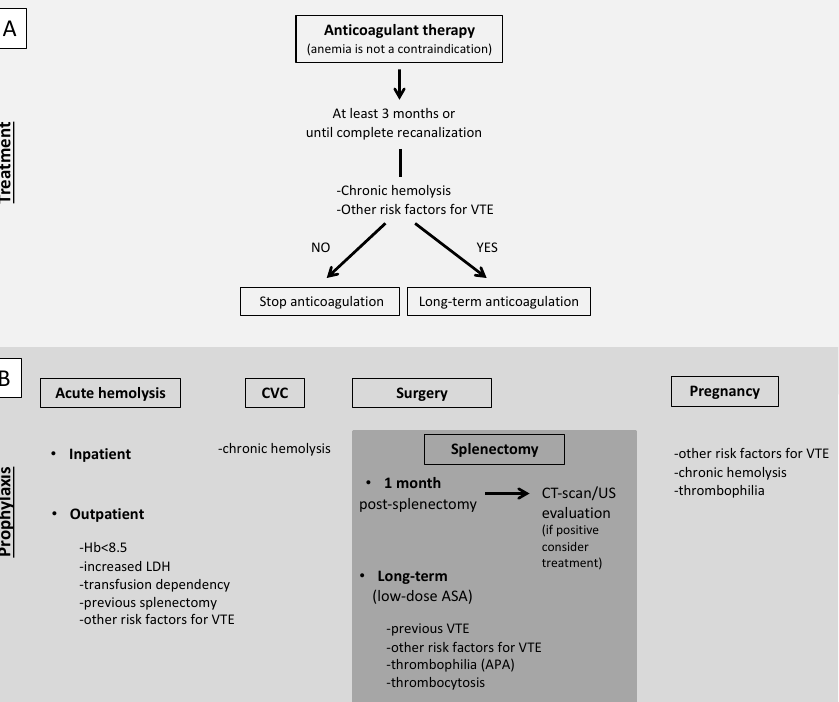
Figure 2. Proposed recommendations for treatment ( A ) and prophylaxis ( B ) of VTE in AIHA patients. ( A ). Anticoagulant therapy should be promptly started, regardless the degree of anemia, and continued for at least 3 months or until complete recanalization. Even if complete recanalization is reached, long-term anticoagulation should be considered for secondary prophylaxis of VTE, evaluating the presence of persistent risk factors for VTE. ( B ). Antithrombotic prophylaxis with low-molecular-weight heparin is recommended for inpatients with acute hemolysis and should be considered for outpatients with acute hemolysis associated with severe anemia, particularly in splenectomized patients or in the presence of concomitant risk factors for VTE. In patients with acute hemolysis undergoing central venous catheter positioning, antithrombotic prophylaxis should be started. We suggest antithrombotic prophylaxis for all patients with chronic immune-mediated hemolysis. In patients undergoing splenectomy, post-operative antithrombotic prophylaxis with low-molecular-weight heparin should be started, unless contraindicated and continued for at least one month when an objective evaluation should be performed before its withdrawal. Long-term anticoagulation or low-dose aspirin should be taken into account in patients with previous VTE or concomitant risk factors for VTE. In pregnant women with chronic hemolysis, antithrombotic prophylaxis should be started, especially in the presence of other risk factors of VTE or thrombophilia abnormalities. VTE, venous thromboembolism; AIHA autoimmune hemolytic anemia; CVC, central venous catheter; CT-scan, computed tomography scan; US, ultrasound; ASA, acetylsalicylic acid; APA, antiphospholipid